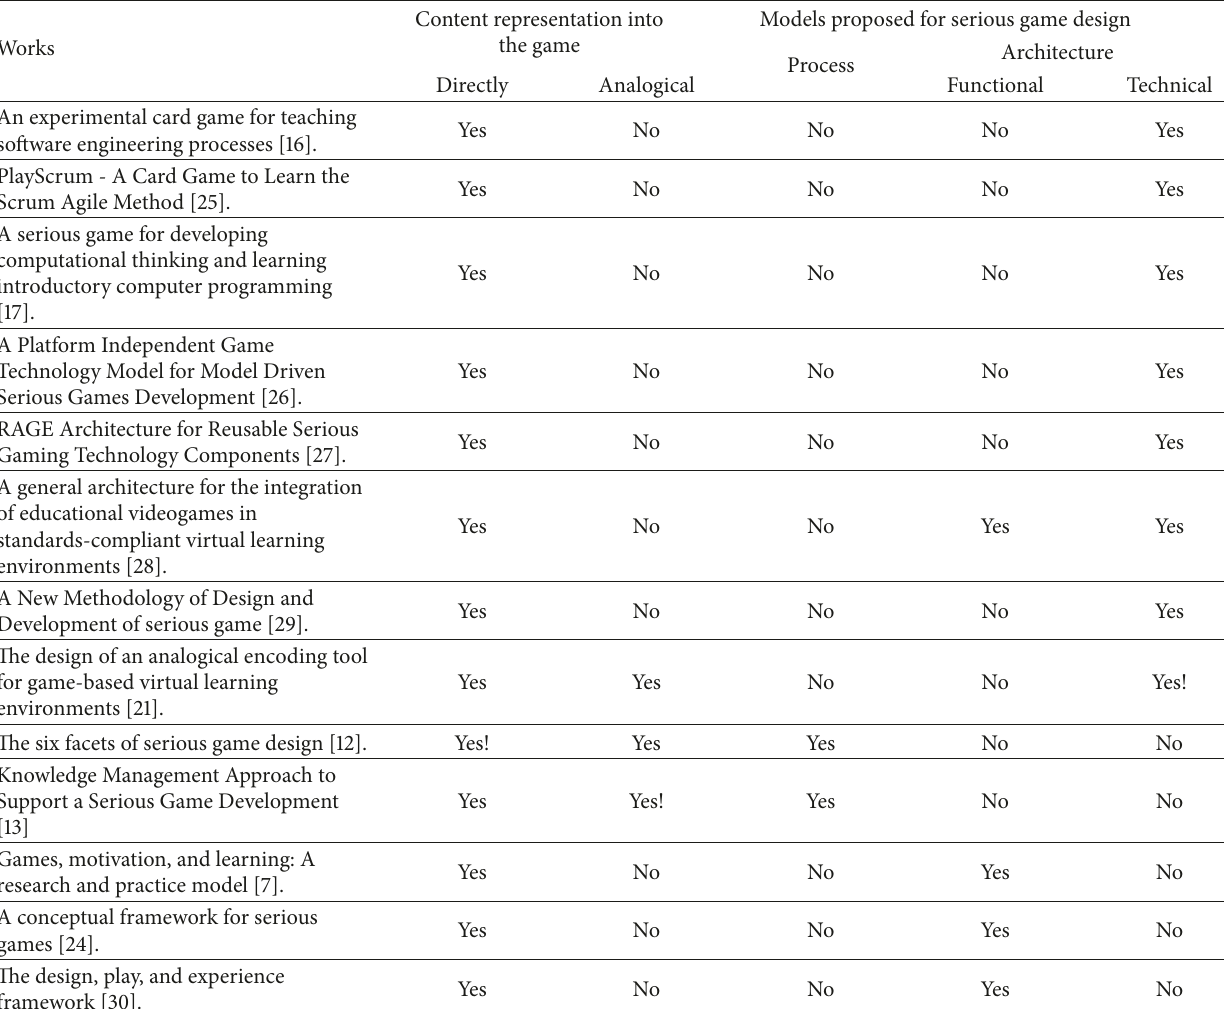
Table 2: Synthesis which presents the classification of serious game and models addressing SG design discussed in state of the art according to the endogenous approach.